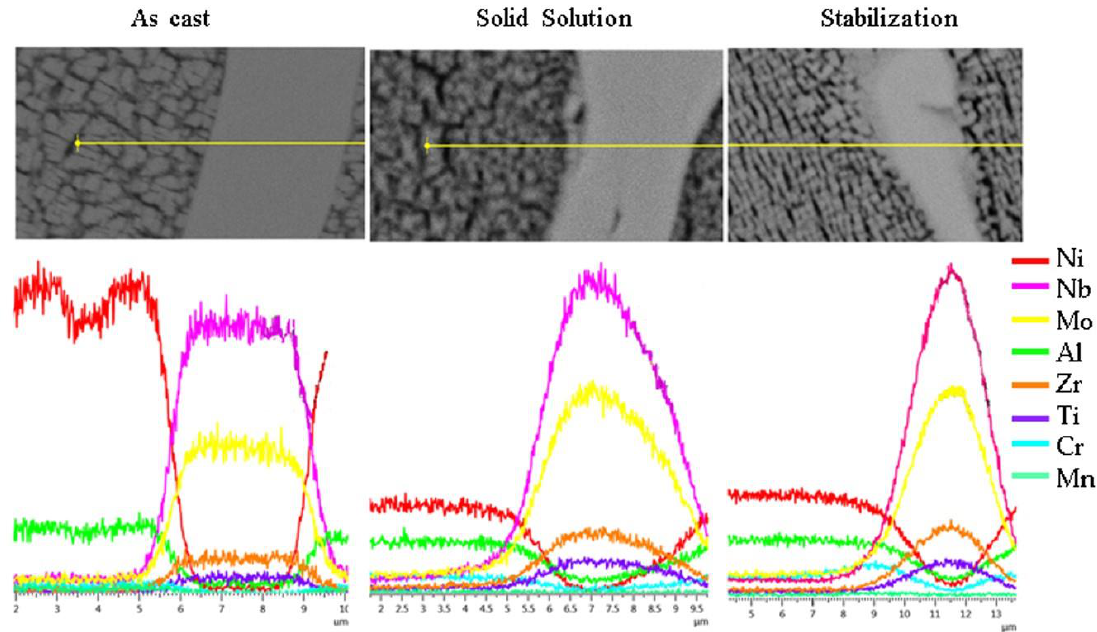
Figure 7. EDS of the samples in the three heat treatment conditions.